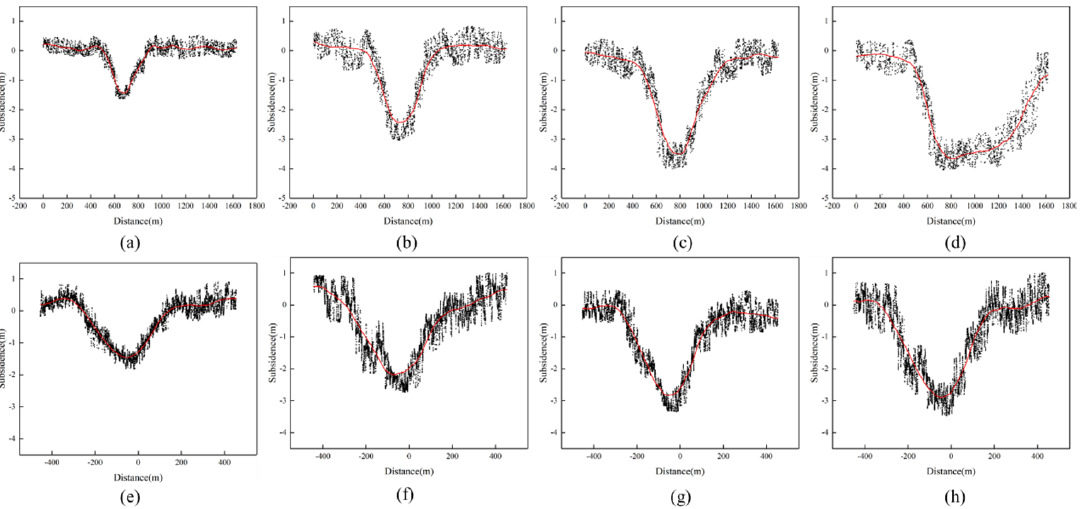
Figure 7. Curve fitting of subsidence and scattered points on the profile line: ( a ) strike 07.20 − 06.14; ( b ) strike 09.07 − 06.14; ( c ) strike 11.15 − 06.14; ( d ) strike 07.31 − 06.14; ( e ) dip 07.20 − 06.14; ( f ) dip 09.07 − 06.14; ( g ) dip 11.15 − 06.14; and ( h ) dip 07.31 − 06.14.